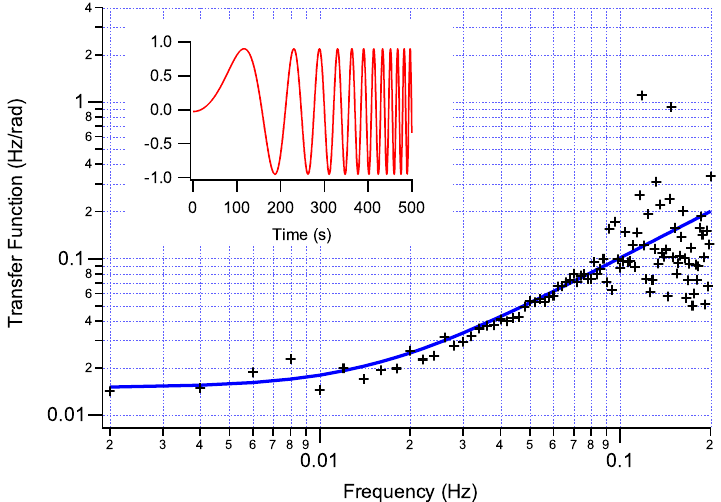
Figure 6. Transfer function of 129 Xe. Inset depicts the normalized chirp waveform used to modulate the bias field. Black crosses are measured data, while the blue line is a fit of the form